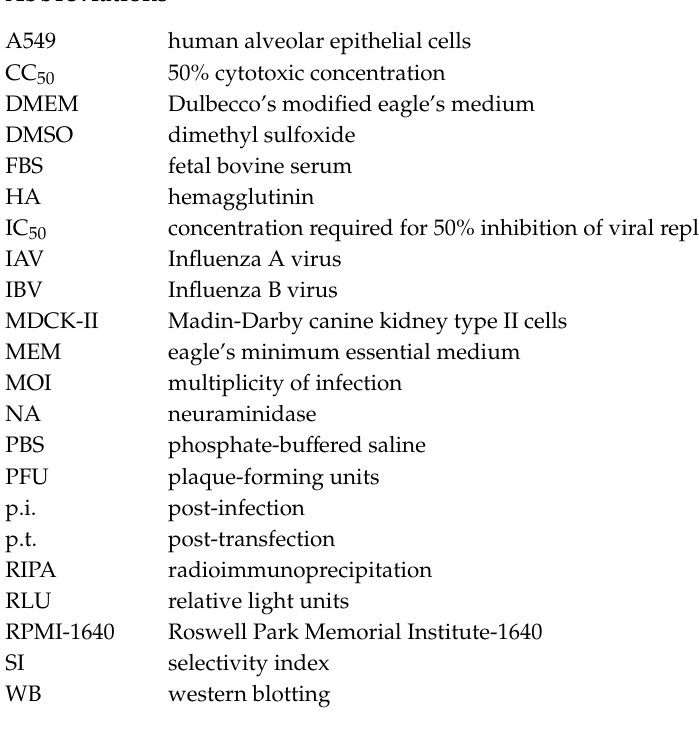
Supplementary Materials: The following are available online, Figure S1: Antiviral activity of new cardenolide derivatives C7c , C10 , C11 and C12 and digitoxigenin against distinct Influenza A and B Virus strains, at 1 µ M. ** p < 0.01, *** p < 0.001 and **** p < 0.0001 vs DMSO, one-way ANOVA, post-hoc test Dunnet; Figure S2: Viability of human tumor-free lung explants after treatment with C10 and C11 . Lung tissue explants were treated and their viability over time was assessed by measuring LDH release in culture supernatants, which were collected at the indicated time points. Results are presented as Optical Densities at 450 nm and have been corrected according to the individual weights of the tissue fragments (mg). The experiment was repeated with lung tissues derived from four independent donors. Each time point represents mean ( ± SEM). DMSO served as solvent control. * p < 0.05 vs MOCK, one-way ANOVA, post-hoc test